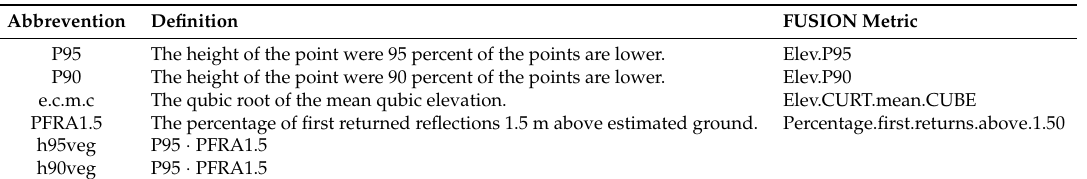
Table 3. The metrics used in the models, defined and described by their corresponding names in the FUSION